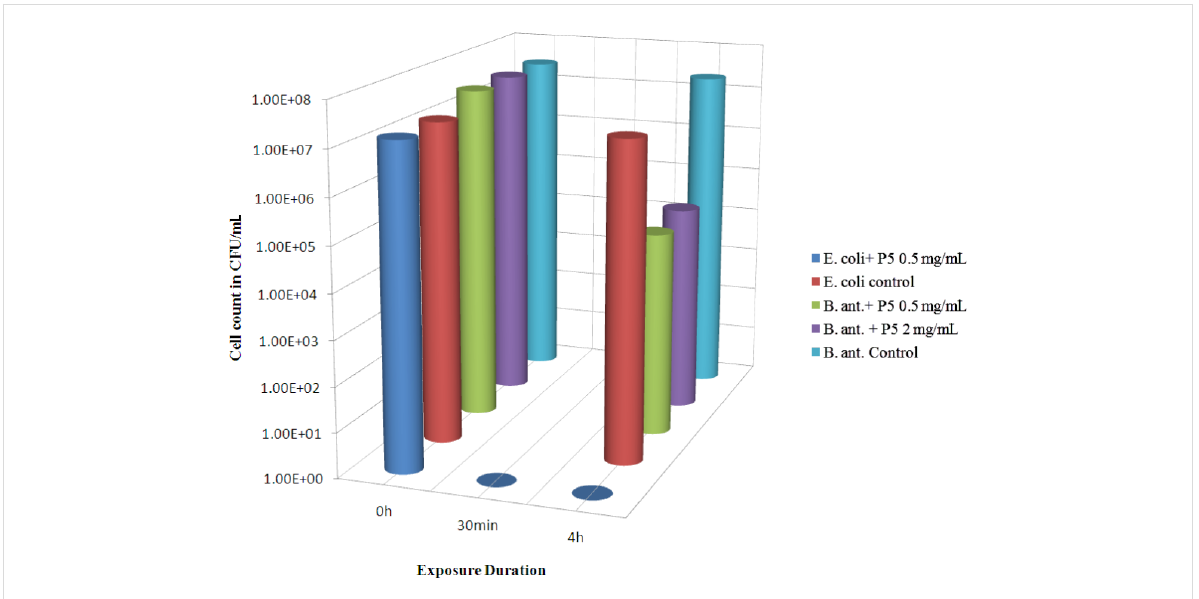
Figure 3: Time dependent bactericidal activity of CuO multi-armed NPs (P5) at doses of 0.5 and 2 mg/mL against B. anthracis vegetative cells and at a dose of 0.5 mg/mL against E. coli cells (both in saline).